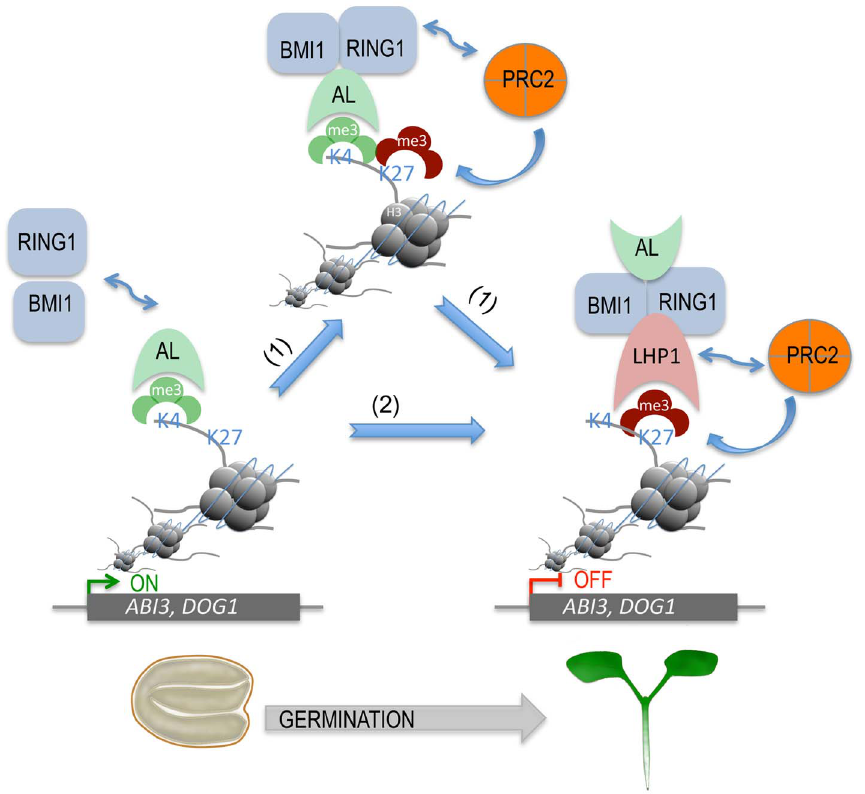
Figure 7. A proposed model for AL PHD-PRC1 complexes in silencing seed developmental genes during seed germination. ALs, via their highly conserved PHD domains, bind H3K4me3 of chromatin, triggering the recruitment of PRC1 components BMI1 and RING1 via AL-AtBMI1, AL-AtRING1, and AtBMI1-AtRING1 physical interactions. Next, two possible pathways (1 and 2) can lead to stable repressive chromatin state formation. In the first case (1), PRC2 is recruited via its subunit CLF interaction with AtRING1 and deposits H3K27me3, favoring further LHP1 recruitment via H3K27me3-LHP1 binding. In the second case (2), LHP1 is first recruited via its interaction with AtRING1 or AtBMI1, and then PRC2 is recruited via its subunit MSI1 interaction with LHP1 and deposits H3K27me3. In both cases, H3K27me3-LHP1 and PRC2 MSI1-LHP1 interactions form a positive loop in H3K27me3 enrichment. This hypothetic model can explain how seed developmental genes ( e.g. ABI3 , DOG1 ) are switched from active transcription to a stably repressed state, which is necessary for timely seed germination and proper seedling growth and